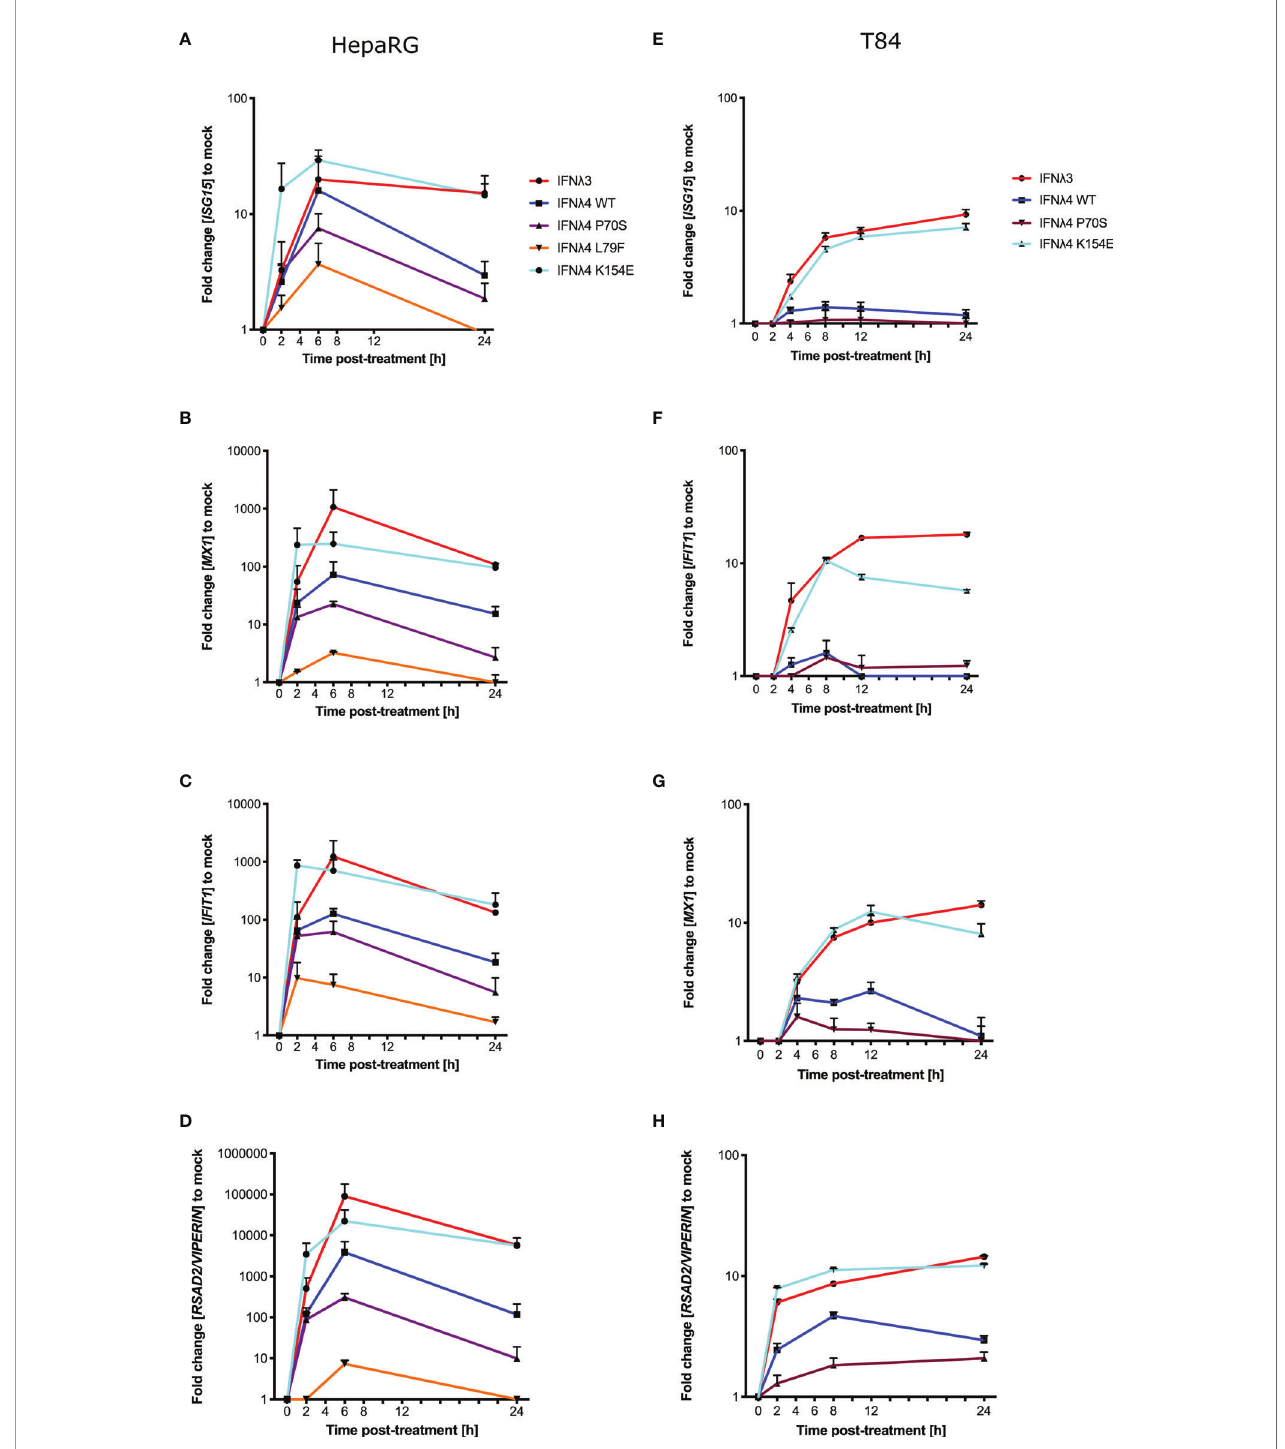
FIGURE 2 | IFN l variants induce unique magnitudes of ISG mRNA. HepaRG (A – D) and T84 (E – H) cells were incubated with IFN l s [IFN l 3-HiBiT (red); IFN l 4-HiBiT: WT (blue), P70S (purple), L79F (yellow), and K154E (cyan)] for indicated times. At the respective time, total RNA was isolated, and qRT-PCR was performed for ISGs: IFIT1 (A, E) , ISG15 (B, F) , MX1 (C, G) , and RSAD2/VIPERIN (D, H) . Mock control cells were treated with conditioned media from EGFP-plasmid transfected HEK-293T cells, and all values were normalised against this value at each time. GAPDH (HepaRG) or HPRT1 (T84 cells) were used as housekeeping genes. L79F did not induce any detectable ISG induction in T84 cells. Error bars represent the mean ± SEM from two to three biological replicates from at least two independent protein